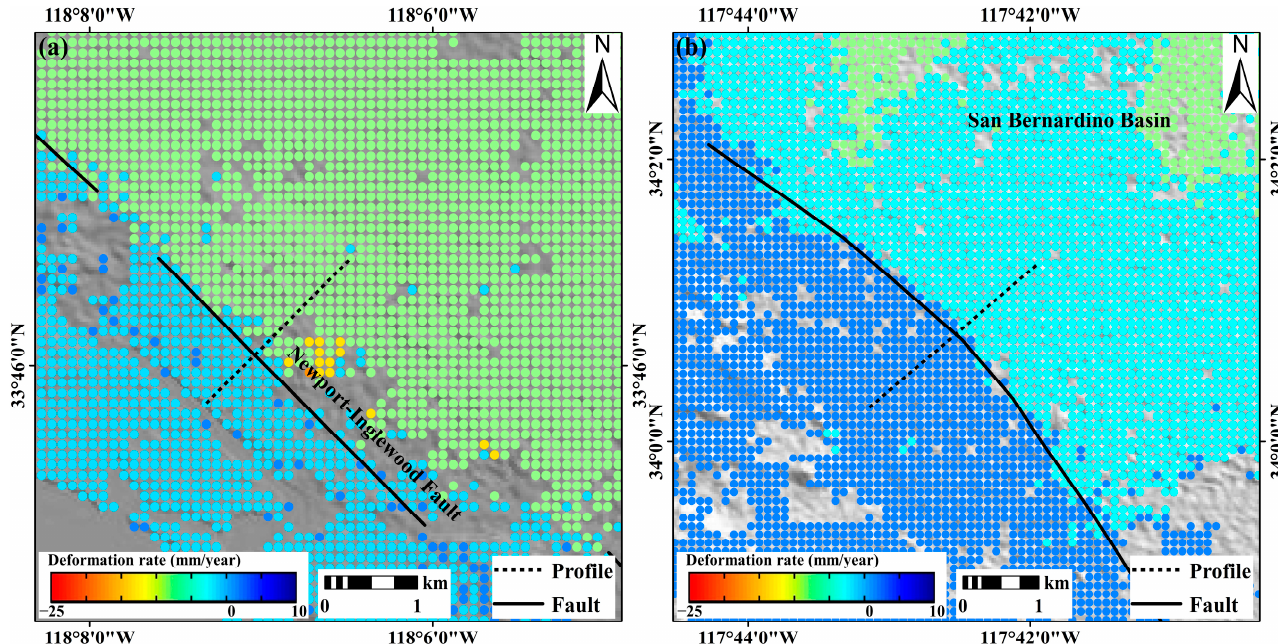
Figure 9. Land deformation rate and time series of three subsidence area. ( a – c ) is Santa Ana Basin, Pomona–Ontar Basin, and San Bernardino Basin; ( d – f ) Corresponding time series of deformation center; ( g – i ) the result of deformation rate that is extracted along the profile.